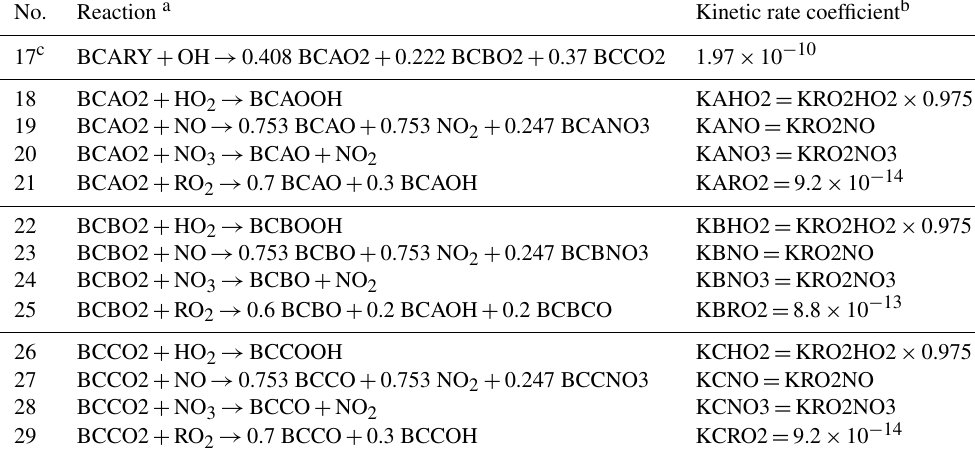
Table 3. Explicit reactions of the MCM species BCAO2, BCBO2, and BCCO2 in the degradation scheme of β -caryophyllene (BCARY). No. Reaction a Kinetic rate coefficient